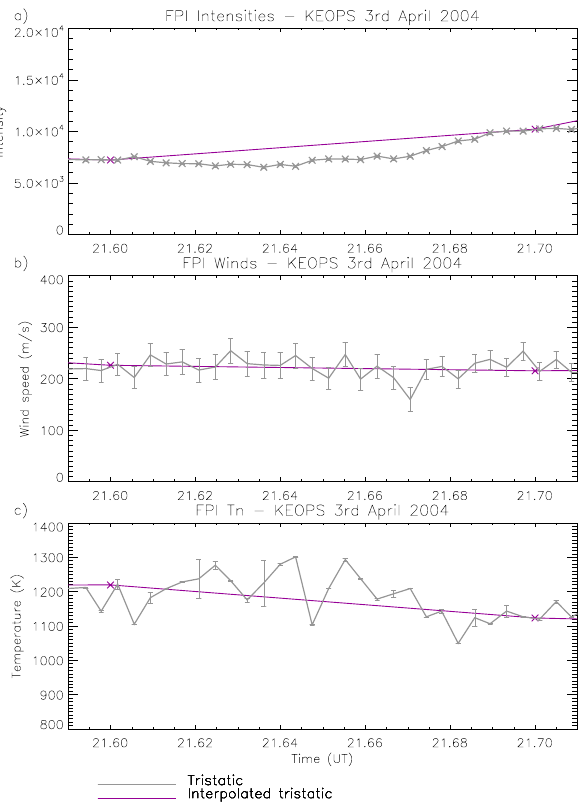
Fig. 5. 10min of high resolution FPI data from KEOPS on 3 April 2004 from a low SNR period, including 0.1hr interpolated tristatic data (purple line): (a) intensities, (b) winds, and (c) temperatures.